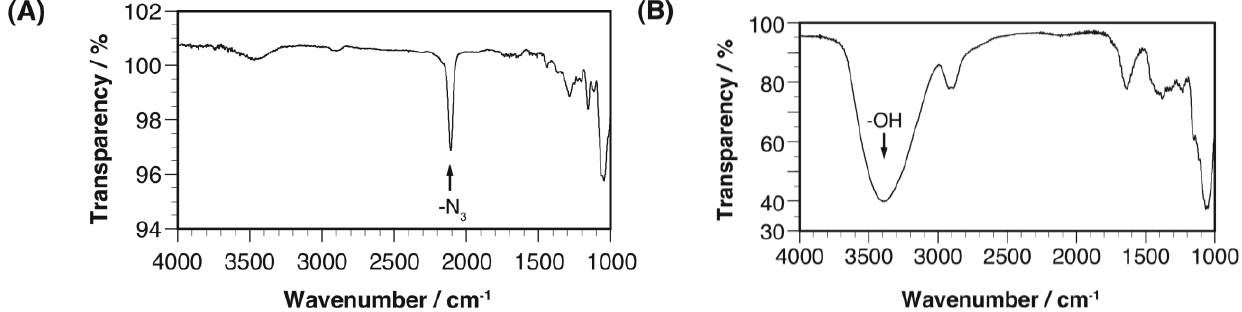
and ( B ) Cel- O -Mal: KBr. 3